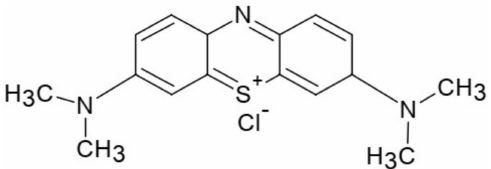
Figure 1. Structure of methylene